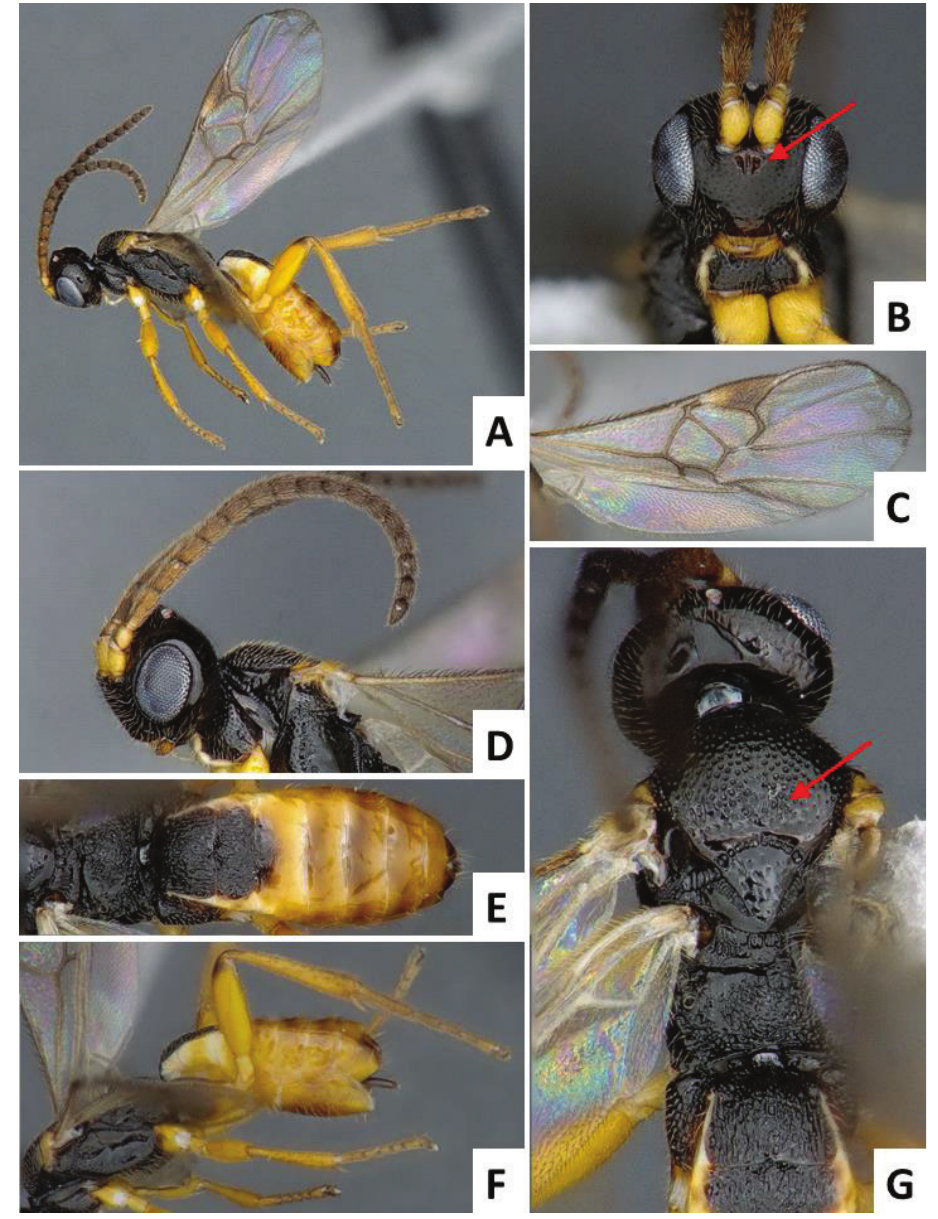
Figure 1. Cotesia typhae , holotype, female specimen from Makindu, Kenya. A Habitus, lateral view B Head, frontal view (arrow shows face projection between antennal base) C Wings D Head and meso- soma (partially), lateral view E Propodeum and metasoma, dorsal view F Mesosoma and metasoma, lateral view G Head, mesosoma and tergites 1-2, dorsal view (arrow shows anteromesoscutum